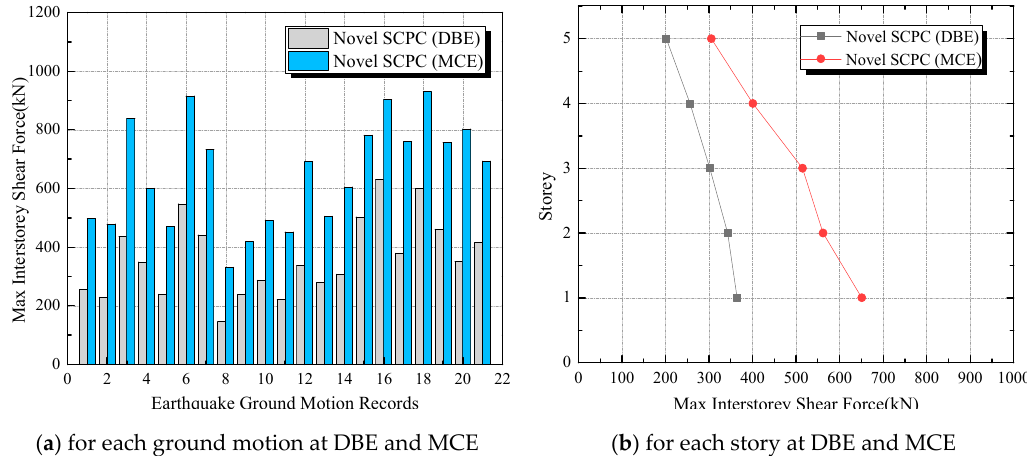
Figure 16. Maximum inter-story shear force for each near-fault ground motion and for each story.